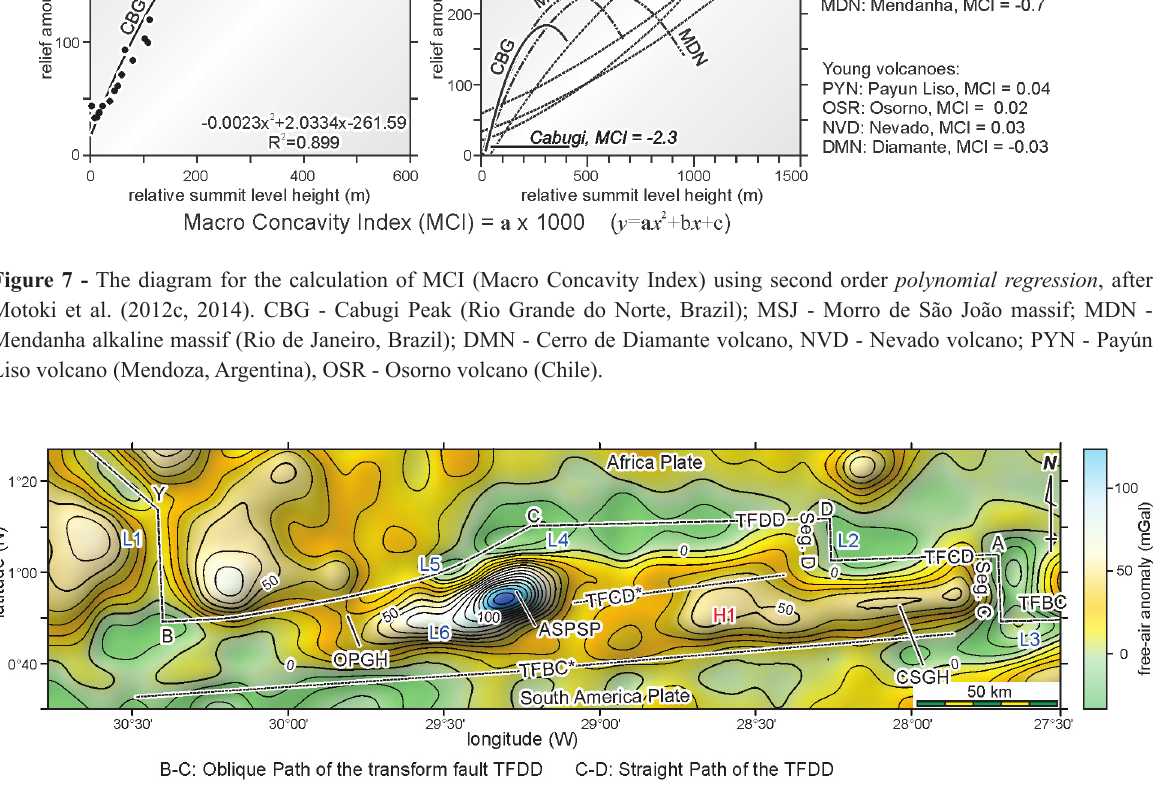
Figure 8 - Free-air anomaly map in mGal based on EGM2008 data set. The plate boundary is according to the proposal of Sichel et al. (2011). The name of the transform faults, abyssal fracture zones, and mid-ocean ridge segments are the same of Figure